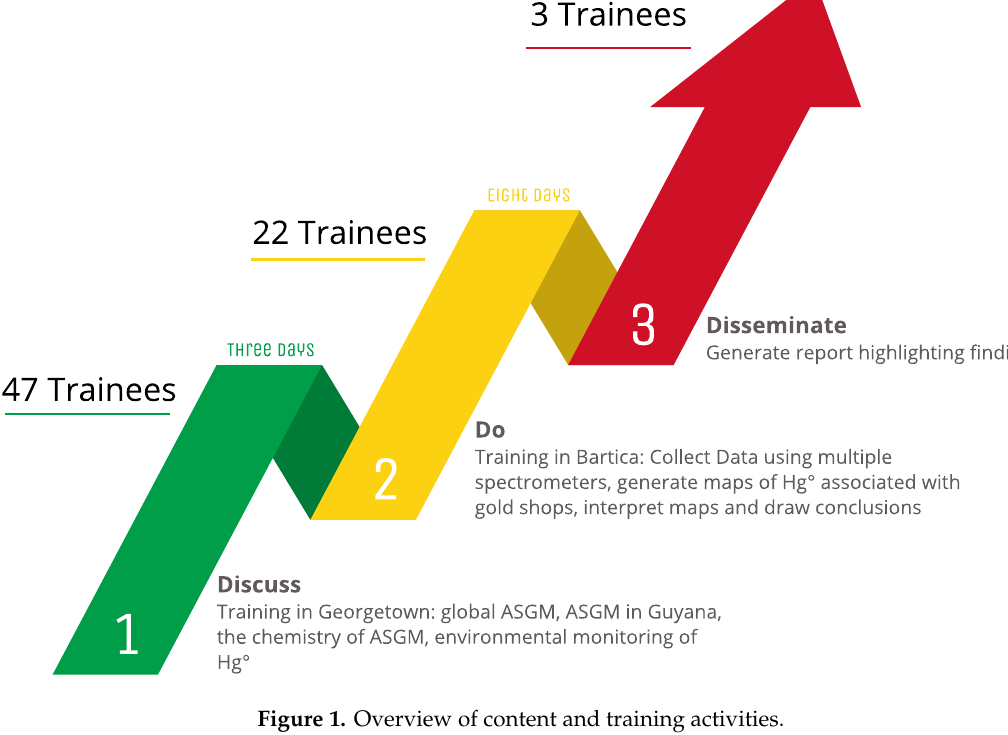
Figure 1. Overview of content and training activities.